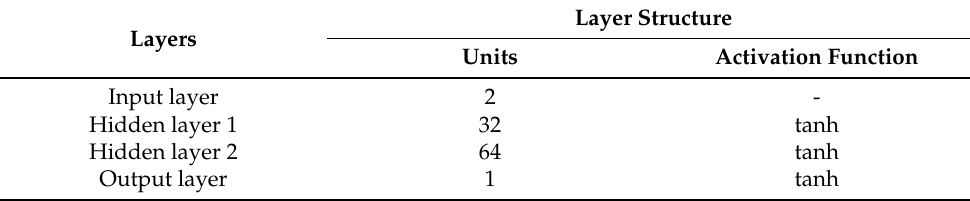
Table 4. The structure of actor network µ ( s ; θ µ )